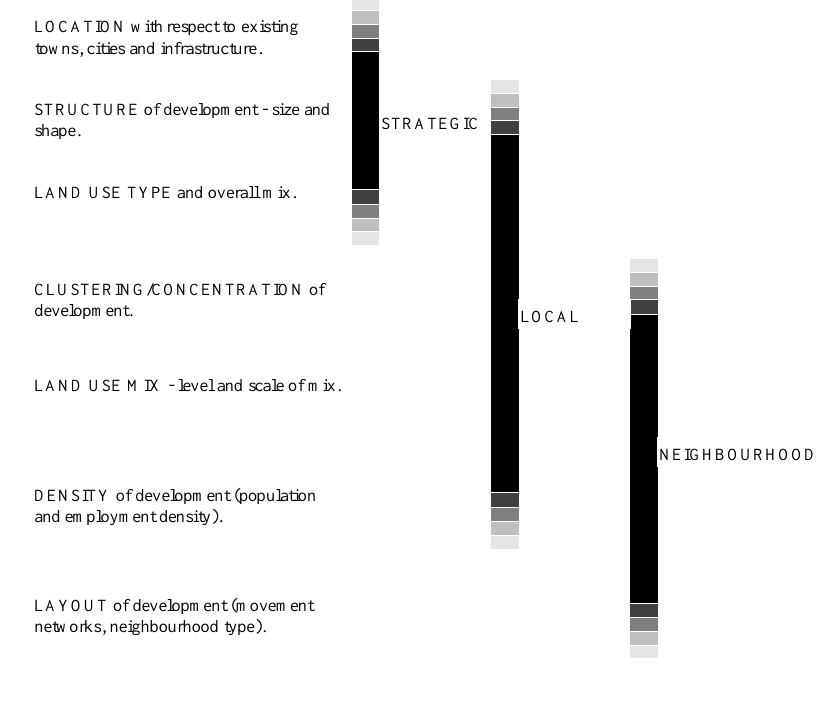
Figure 1. Land use characteristics that can affect travel